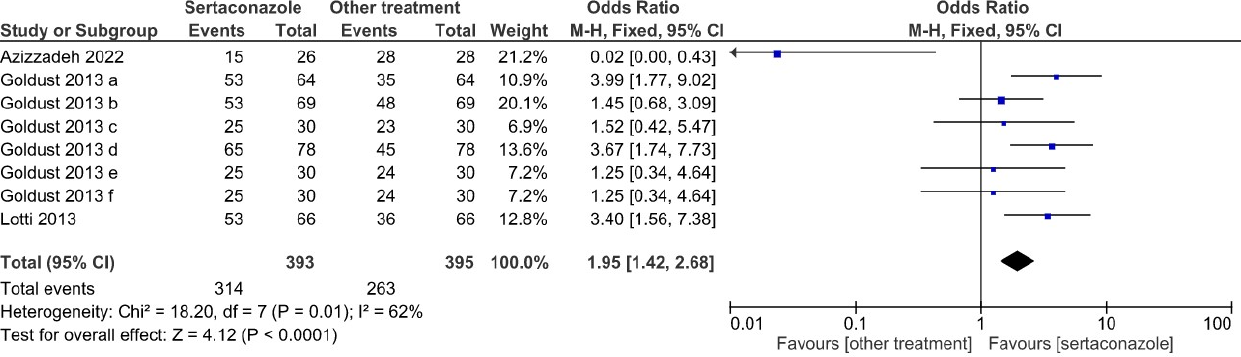
Figure 4. Forrest plot illustrating the effect of sertaconazole vs. other treatments in the eight selected studies for the moderate and severe SI at 28 days of treatment (OR with 95% confidence interval, heterogeneity, and overall effect). Figure 5 illustrates a Forrest plot for the analysis of frequencies of patients indicating a “good” ranking in the satisfaction self-assessment questionnaire administered at 28 days of treatment; the OR was 3.00 (95% confidence interval 2.13–4.23), again favoring sertacon- azole vs. other treatments. The heterogeneity test yielded a χ 2 value of 20.12 ( p = 0.005), and the overall effect a z of 6.30 ( p < 0.00001).